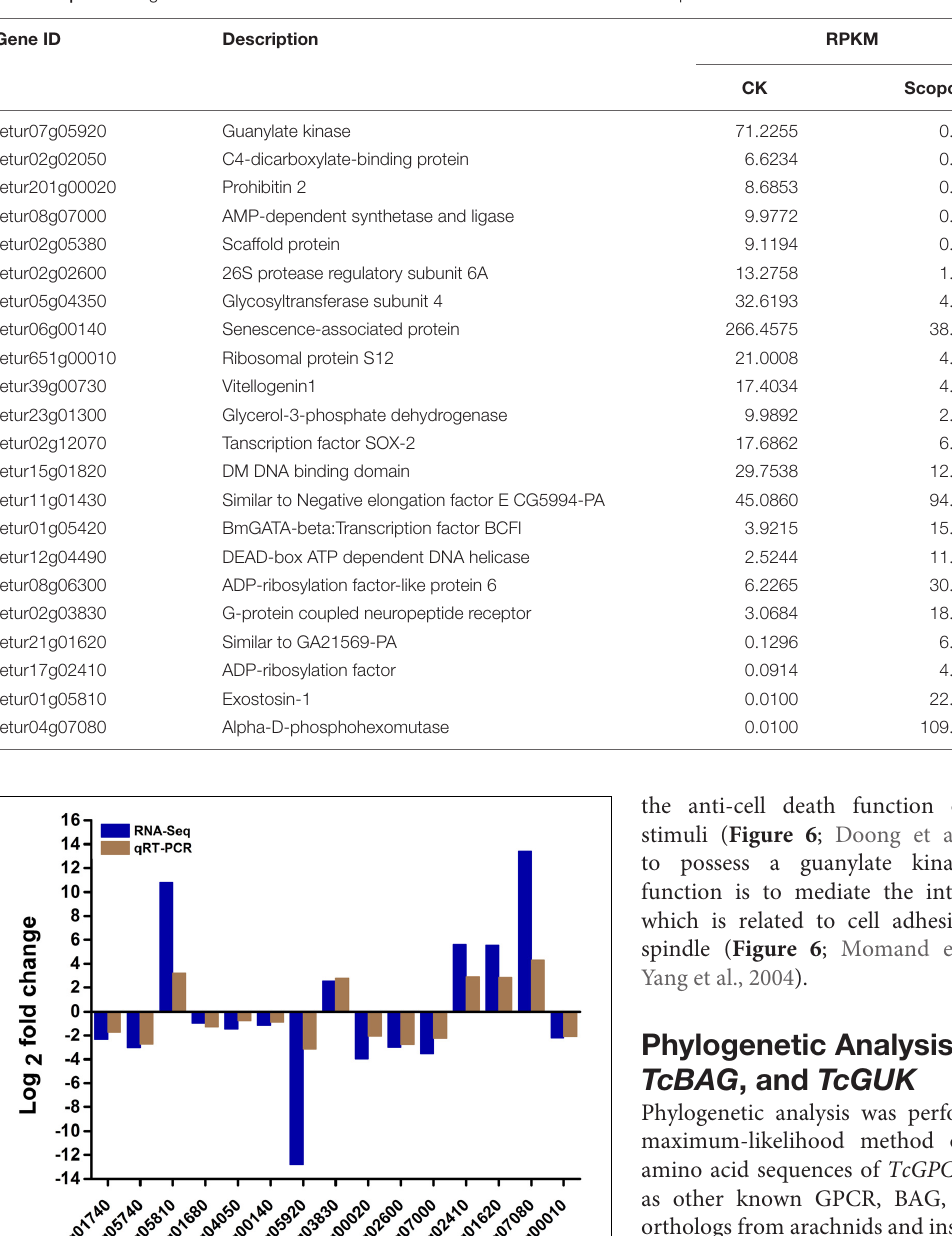
TABLE 3 | Selected genes involved in mite detoxification and acaricide metabolism at 48 h posttreatment.